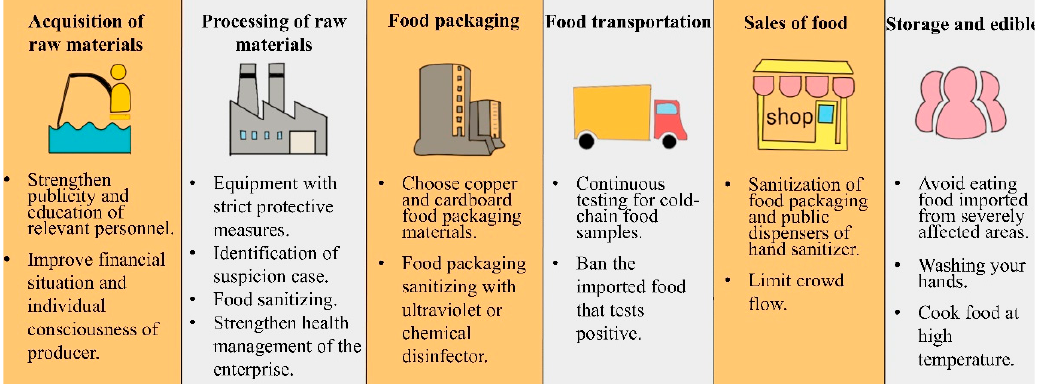
Figure 1. The possible solutions for the potential SARS-CoV-2 contaminated risks during the six links in the